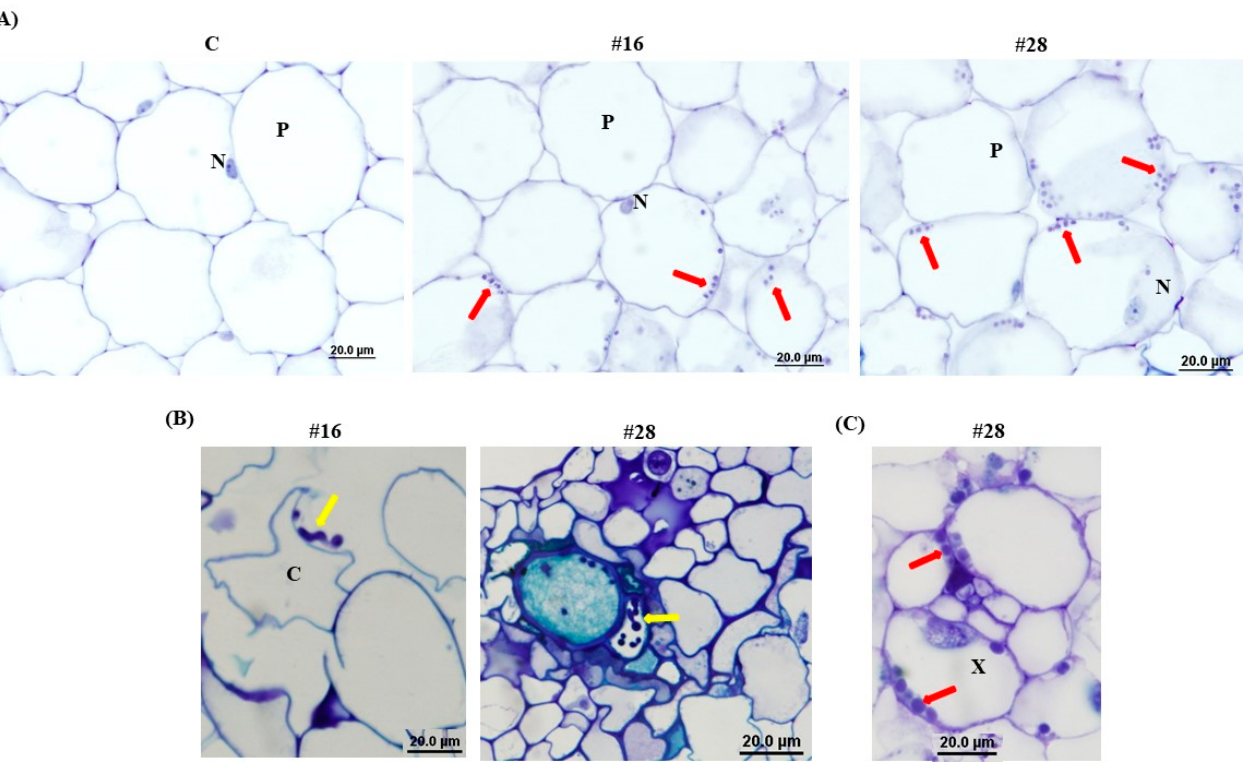
Figure 2. Colonization of endophytic BCAs in root tissues of date palm. Light micrograph of semi- thin sections of date palm root tissues ( A ) non-inoculated control (C; left), or inoculated with either isolate #16 (BCA1; middle) or #28 (BCA2; right) (1000X); ( B ) spore germination within the root cortex cells inoculated with either isolate #16 (left) or #28 (right) (1000X) and ( C ) spores of isolate #28 in the root xylem of date palm (1000X). In ( A – C ), all sections were stained with 0.1% toluidine blue showing the distribution of spores in root tissues (red arrows) and germinating spores within the root cells (yellow arrows) of date palm. Bars: 20 µ m. Isolates #16 and #28 represent Streptomyces polychromogenes UAE2 and Streptomyces coeruleoprunus UAE1, respectively. BCA, biological control agent; P, pith, N, nucleus; C, cortex; X,